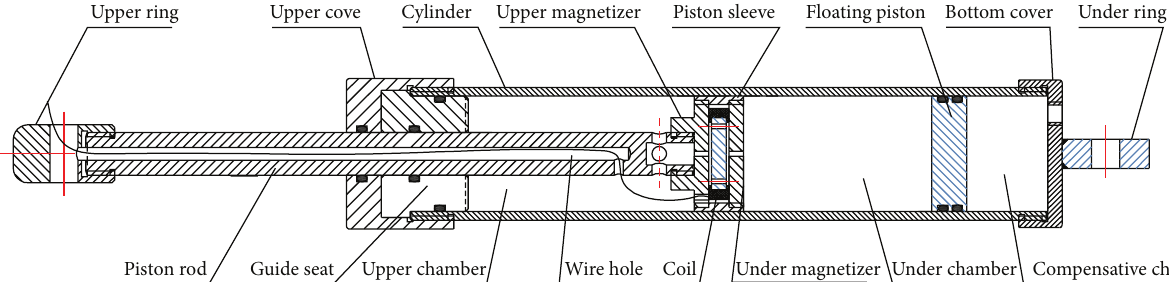
Figure 4: The assembly diagram of MR